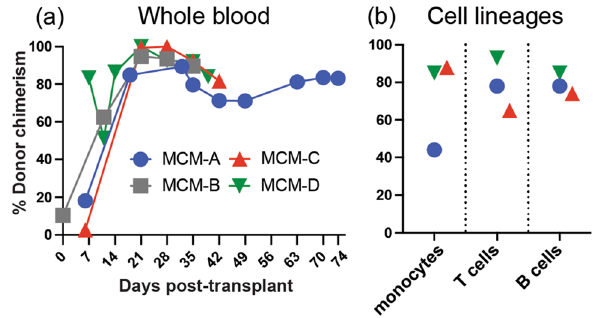
Figure 3. Donor chimerism after allo-HSCT. We determined donor chimerism levels post-transplant by sequencing SNPs differing between the donor and recipient. ( a ) Longitudinal percent donor chimerism in whole blood after allo-HSCT. ( b ) At necropsy, the percent donor chimerism among flow cytometry sorted PBMC monocytes (CD45 mid CD14 + lymphocytes), T cells (CD14 - CD45 hi CD3 + lymphocytes), and B cells (CD14 - CD45 hi CD20 +